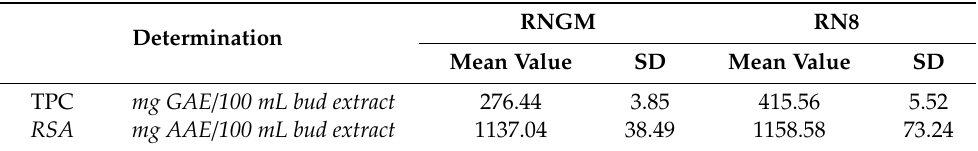
Table 2. Total phenolic compounds (TPC) and radical scavenging activity (RSA) of the most promising R. nigrum extract obtained by pulsed ultrasound-assisted extraction (PUAE) (RN8) compared to the corresponding commercial product (RNGM).